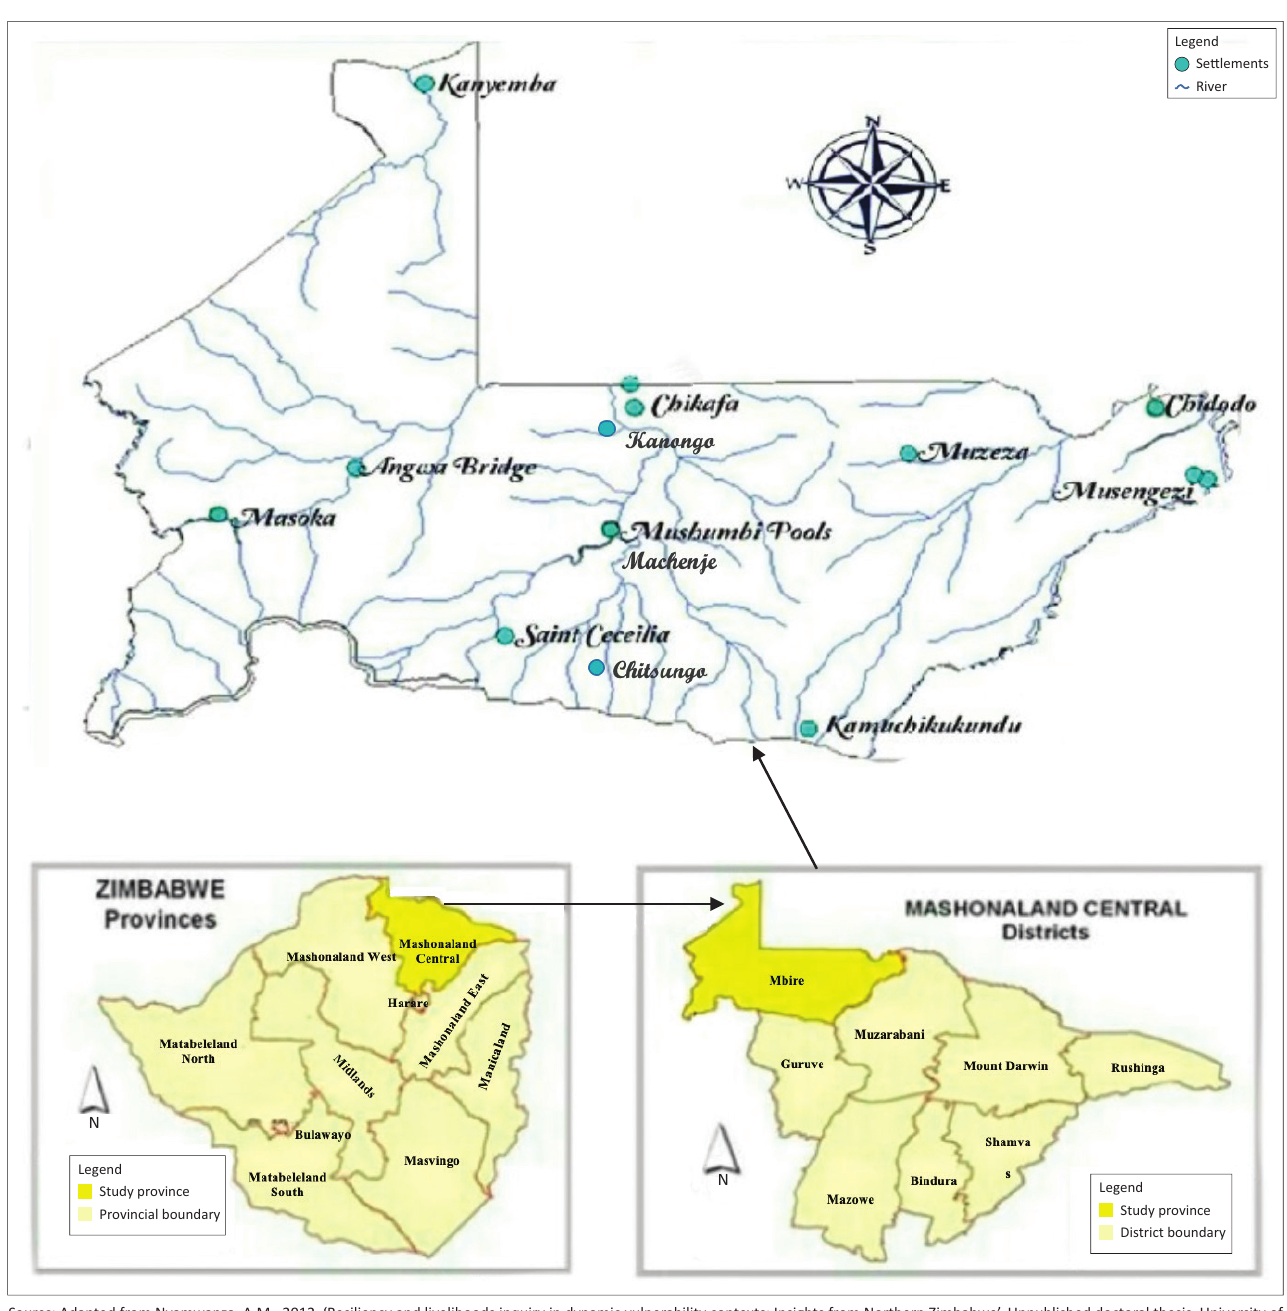
FIGURE 2: Maps depicting Mashonaland Central province, Mbire